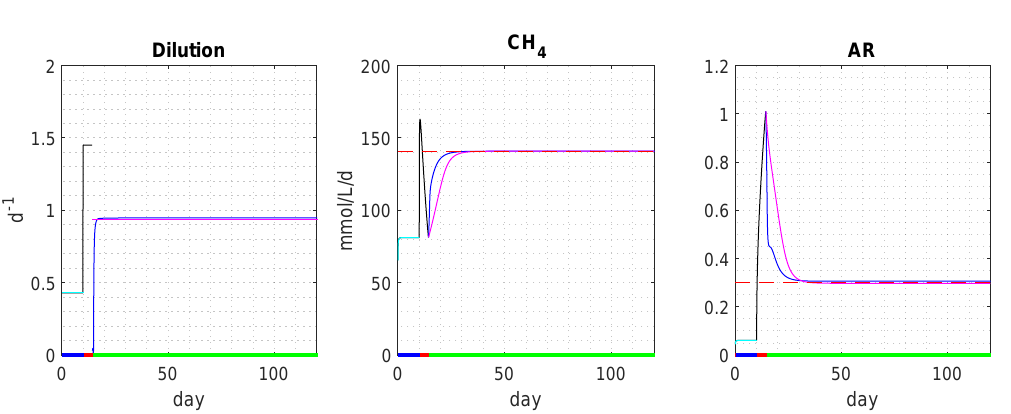
Figure 5: Optimal recovery of methane production based on AR threshold equals 1. In time axis, the blue band is a stable operating condition. The red band represents unhealthy condition and the green band is the recovery period.